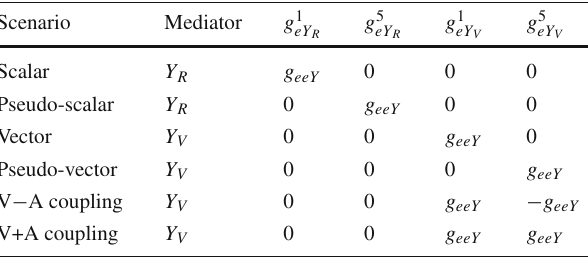
Table 2 Summary of mediator scenarios considered in the presented study